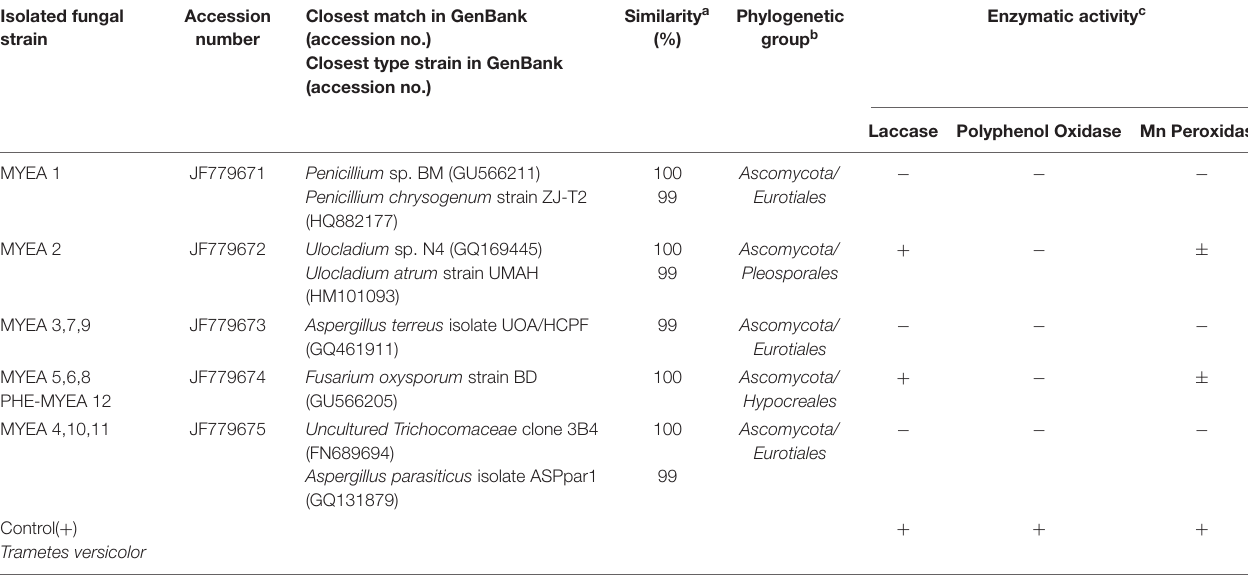
TABLE 2 | Preliminary identification of the isolated fungal strains by sequencing of the ITS1-ITS2 rRNA region, and enzymatic screening of the ligninolytic activity. Isolated fungal